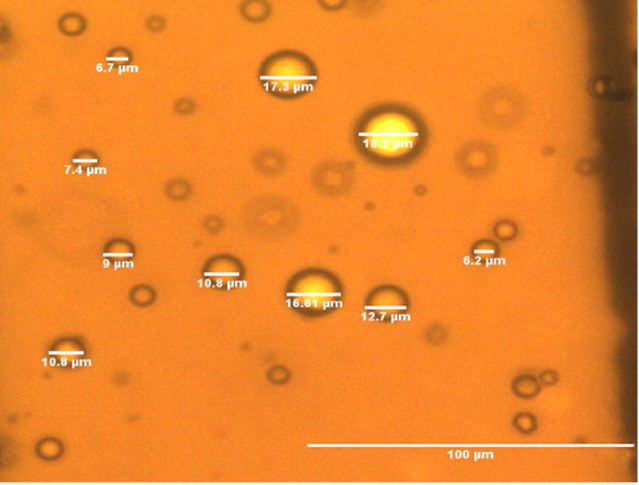
Figure 23. Sample N with 15% ( v / v ) water added. Dg average = 7.9 µm ± 0.01 . Table 9. Process model